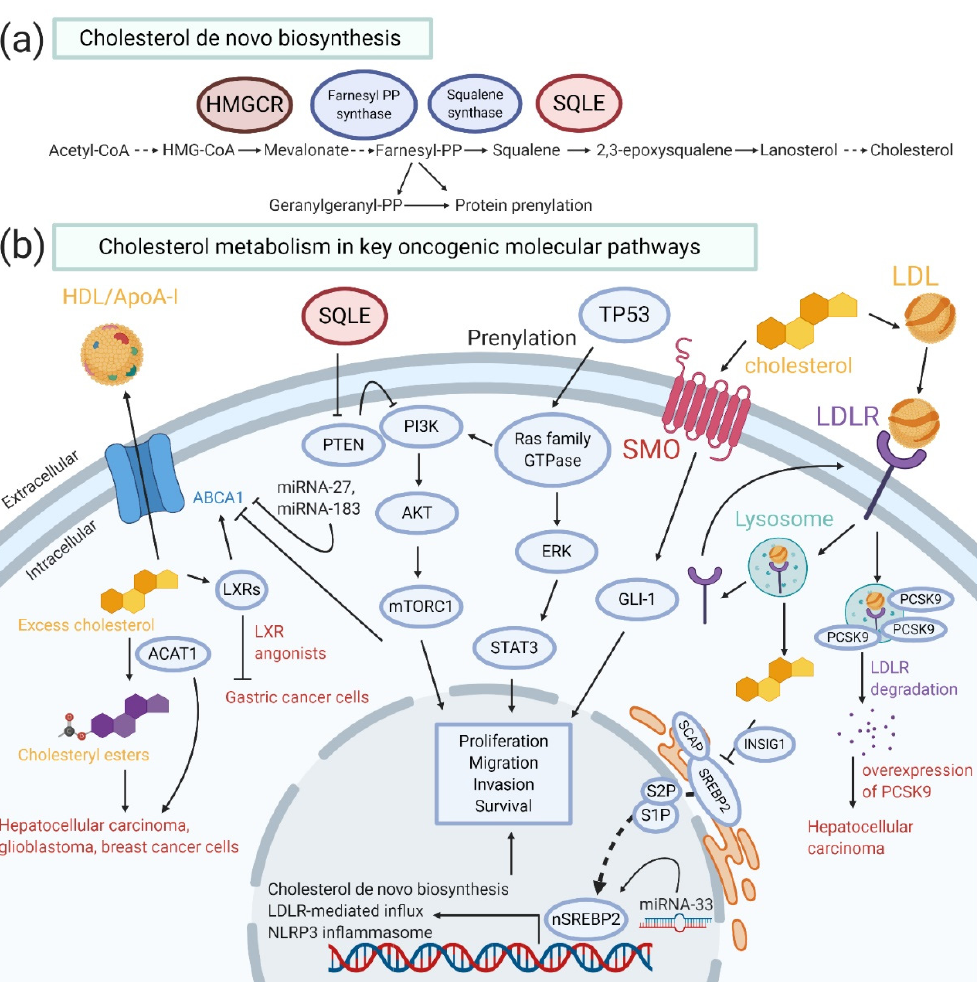
Figure 1. Cholesterol metabolism and key oncogenic pathways related to cancer development. ( a ) Cholesterol de novo biosynthesis. Starting from three molecules of acetyl ‐ coenzyme A (CoA), cholesterol is synthesized in more than 20 enzymatic steps, whereas 3 ‐ hydroxy ‐ 3 ‐ methylglutaryl ‐ CoA reductase (HMGCR) and squalene epoxidase (SQLE) act as rate ‐ limiting enzymes. ( b ) Systematic diagram showing the cholesterol metabolism in relation to key oncogenic molecular pathways. Sterol ‐ regulatory element binding protein 2 (SREBP2) regulates the transcriptional activity of cholesterol biosynthesis genes, low density lipoprotein receptor (LDLR) ‐ mediated cholesterol influx, and Nod ‐ like receptor protein 3 (NLRP3) inflammasome ‐ associated inflammation. Embedded in SREBP2 gene, microRNA (miRNA) ‐ 33 can positively regulate SREBP2 expression. The over ‐ activated cholesterol biosynthesis contributes to uncontrolled cell growth. Overexpressed proprotein ‐ convertase ‐ subtilisin ‐ kexin type ‐ 9 (PCSK9) facilities the lysosomal degradation of LDLR, induces hypercholesterolemia, and eventually leads to the development of hepatocellular carcinoma. Excess